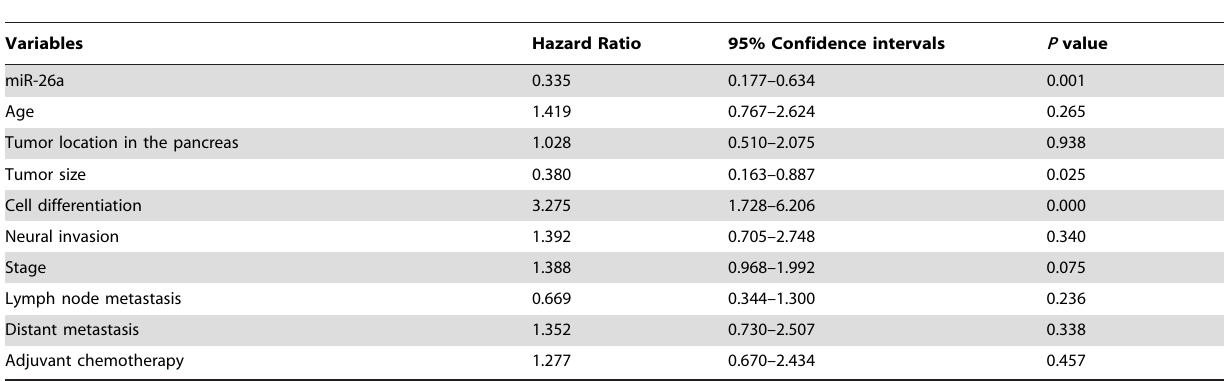
Table 3. Mutivariate survival analysis (Cox regression model) of conventional clinical prognostic factors and miR-26a.